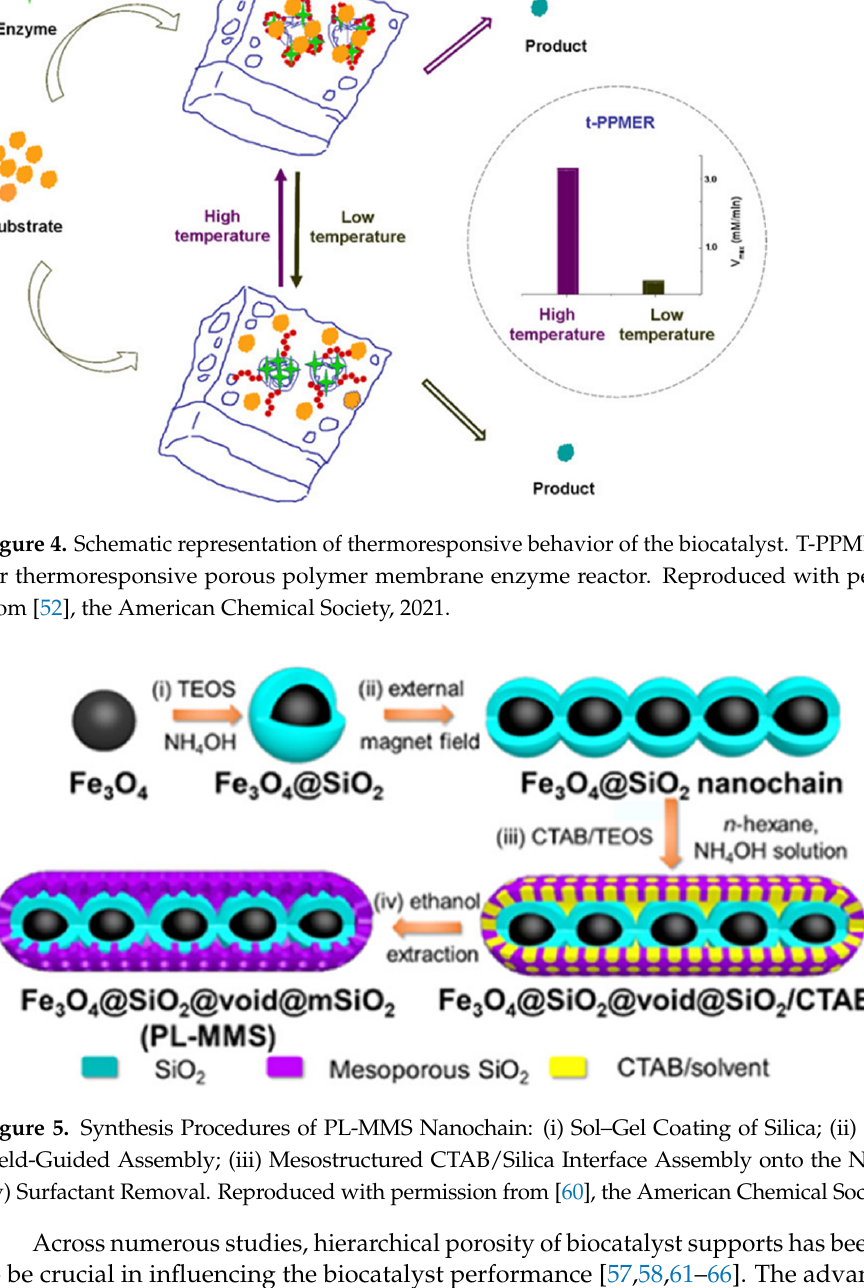
Figure 4. Schematic representation of thermoresponsive behavior of the biocatalyst. T-PPMER stands for thermoresponsive porous polymer membrane enzyme reactor. Reproduced with permis- sion from [52] , the American Chemical Society, 2021.